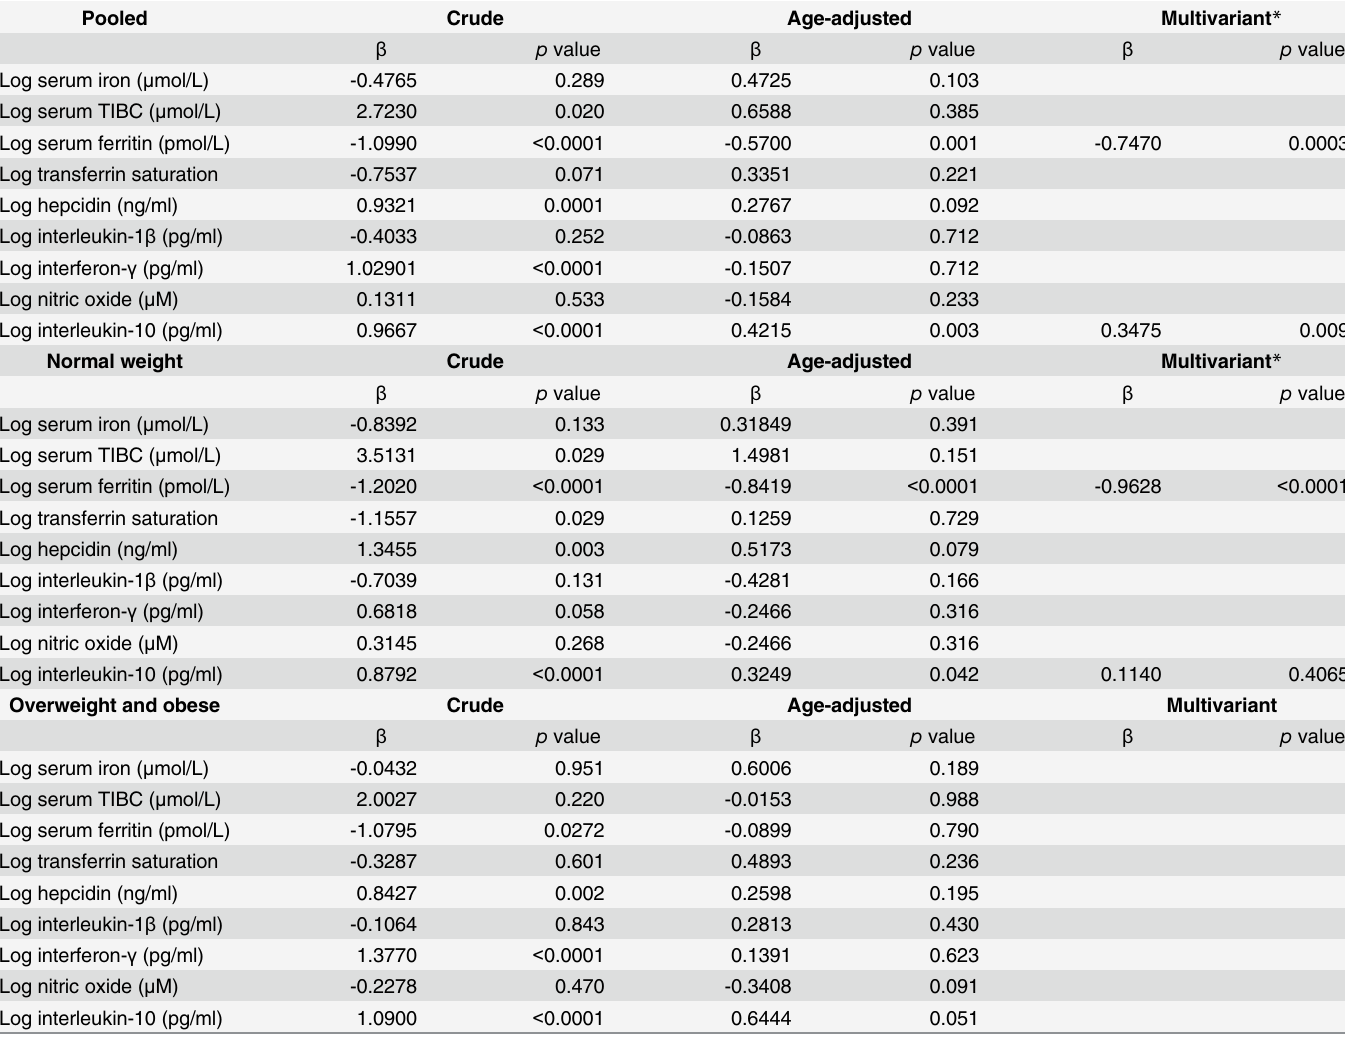
Table 5. Multivariate regression coefficients for log-transformed serum testosterone in relation to the nutritional status in 137